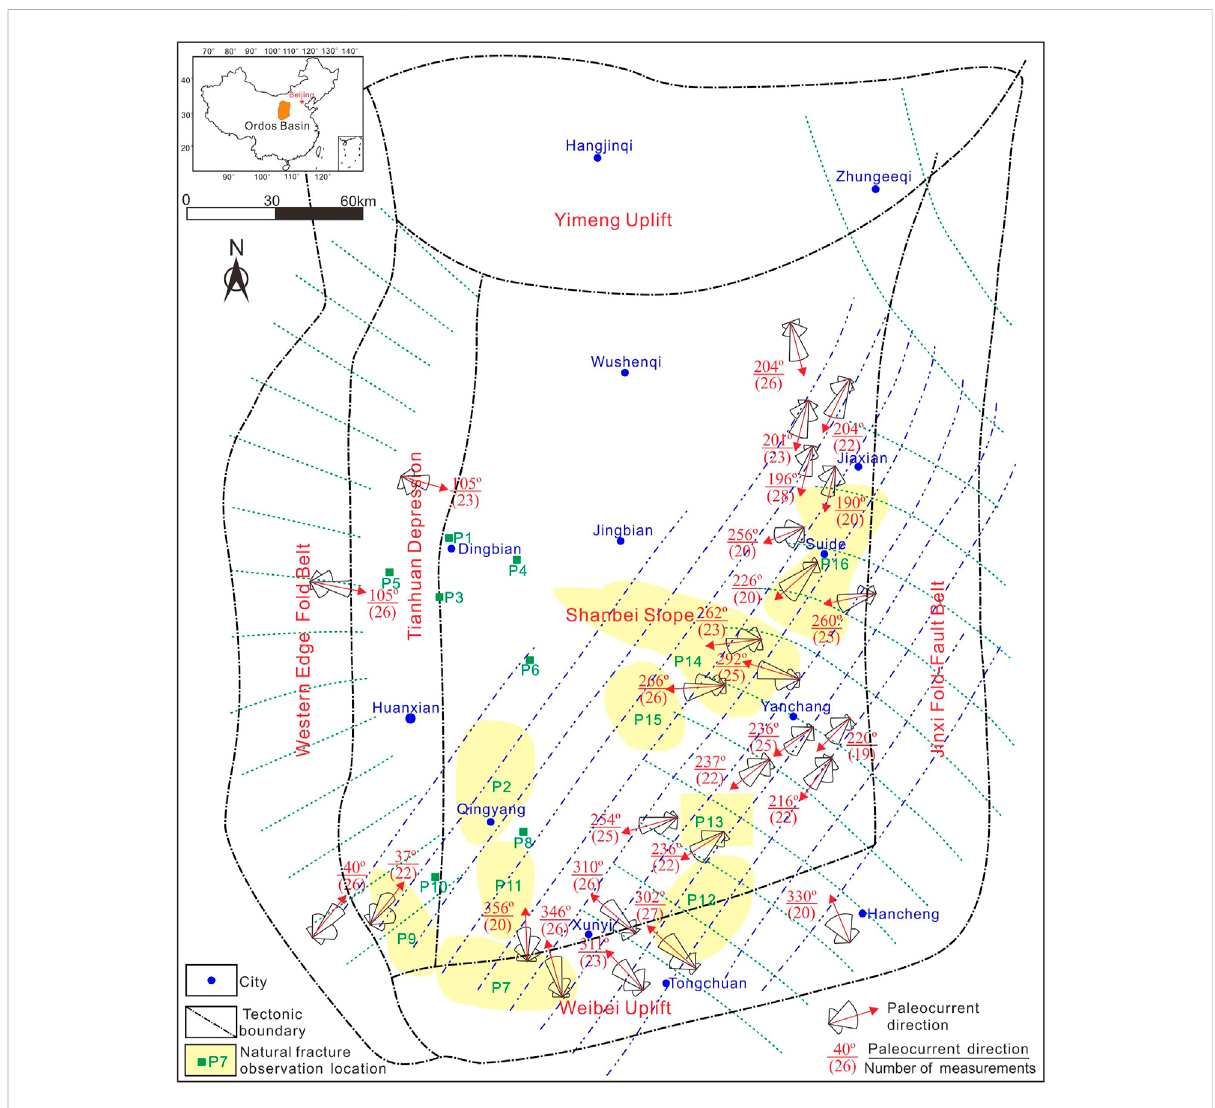
FIGURE 1 Distributionofthetectonicstress fi eldandpaleocurrentsintheOrdosBasin.ThepaleocurrentdirectionsintheYanchangFormationareshown for the earlyand middle stages ofsedimentation (Chang 4to Chang 10 oil-bearing formations). The paleocurrentdata were provided by Guo (2016), andthetectonicstress fi elddatawereprovidedbyXuetal.(2006).Thebluedashedlineisthedirectionofthemaximumhorizontalprincipalstressin the Himalayan period, and the green dashed line is the direction of the maximum horizontal principal stress in the Yanshanian